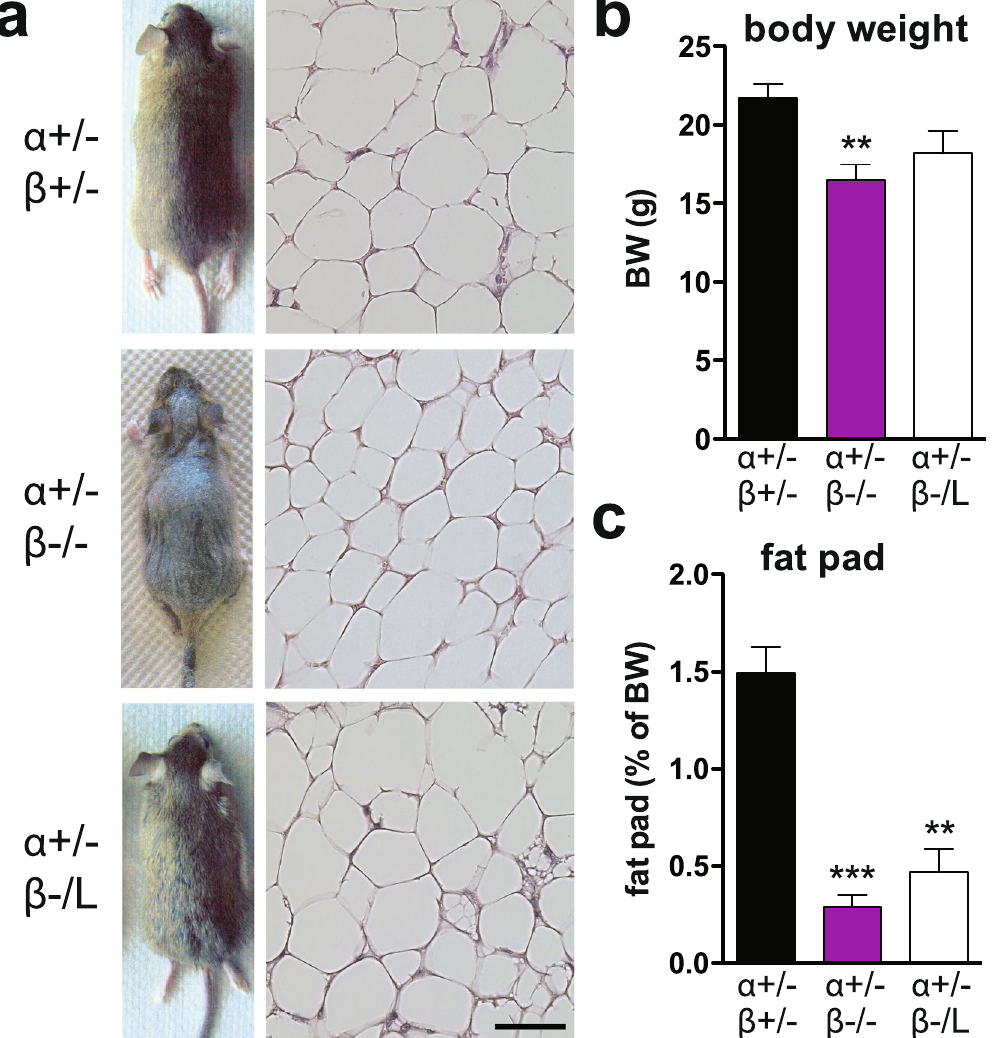
Figure 4. The C/EBP β LIP isoform functions in tandem with C/EBP α in fat and skin homeostasis. ( a ) Representative photographs of the fur (left panels) of Cebpa + / − ; Cebpb + / − , Cebpa + / − ; Cebpb − / − , and Cebpa + / − ; Cebpb − /L mice. H&E staining of white fat sections of Cebpb mutant mice (right panels). Scale bar, 50 μ m. ( b ) Body weight and ( c ) fat pad weight of Cebpa + / − ; Cebpb + / − , Cebpa + / − ; Cebpb − / − , and Cebpa + / − ; Cebpb − /L mice at death. In all panels, data are presented as mean ± SEM. ** P < 0.01, *** P < 0.001 by Student’s t -test. Mice were 8–12 weeks of age, n = 3–7 per